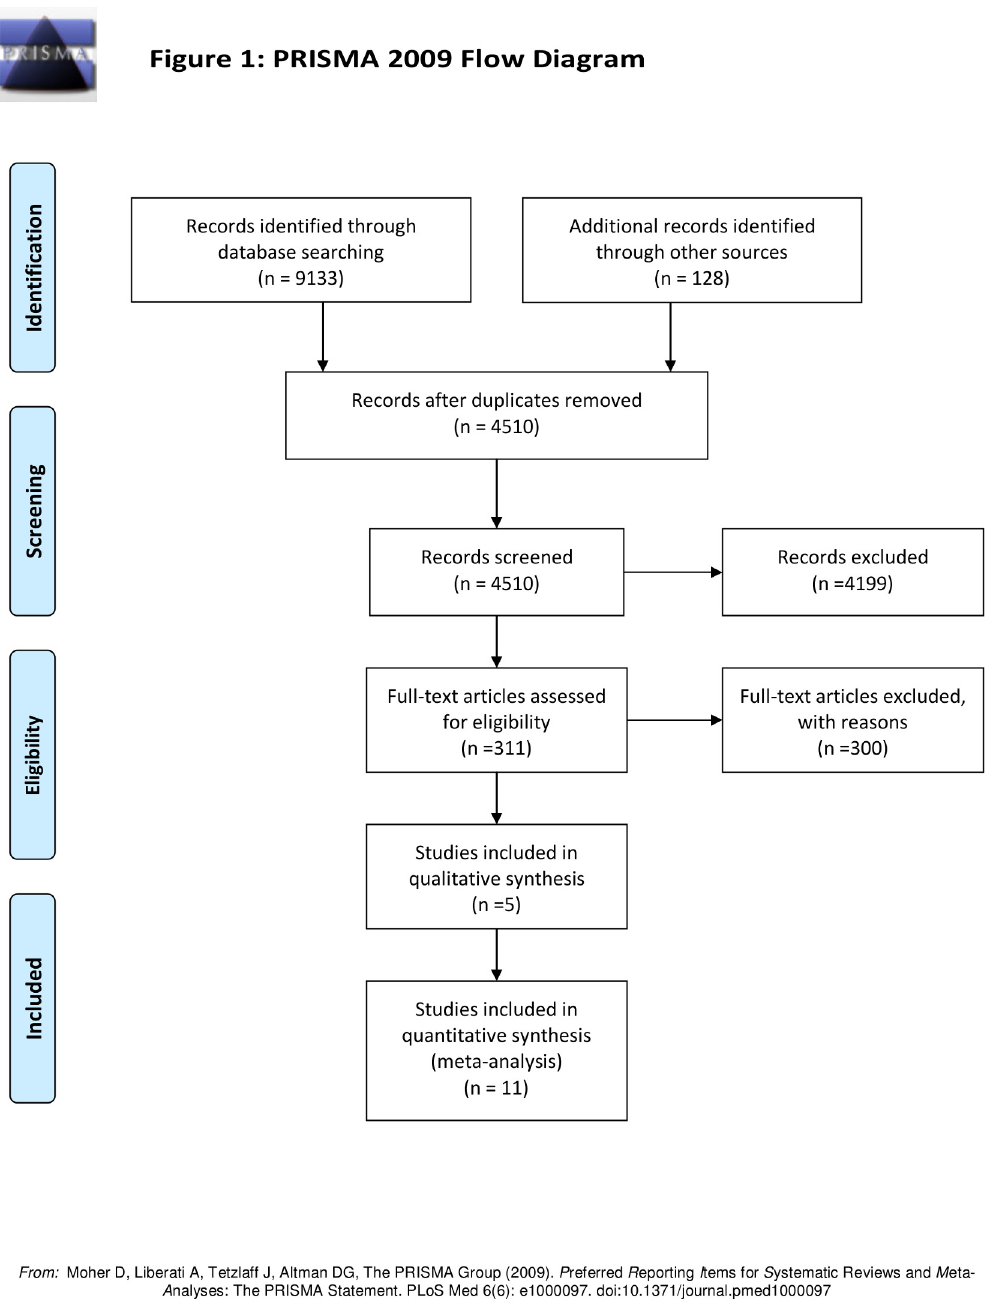
Fig 1. PRISMA Flow Diagram for Immediate versus Delayed Sequential Bilateral Cataract